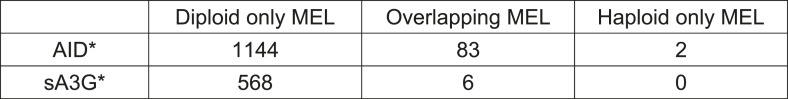
Overlap between Haploid and Diploid MELs.